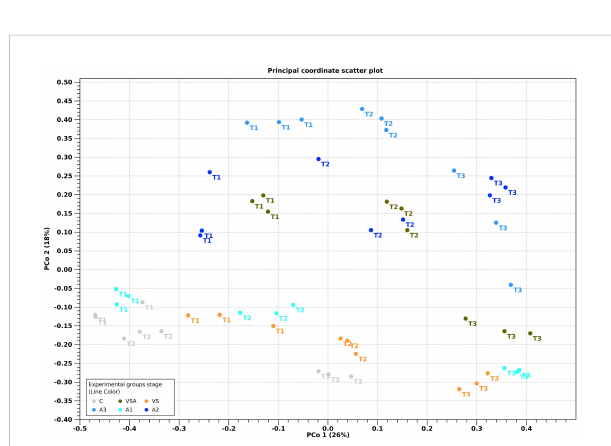
FIGURE 8 Principal coordinate analysis ordination (PCoA) of a Bray-Curtis dissimilarity matrix for the treatment over time. Treatments are color coded: C (Control, gray), VSA (brown), VS (orange), A1 (baby-blue), A2 (blue), A3 (navy-blue).